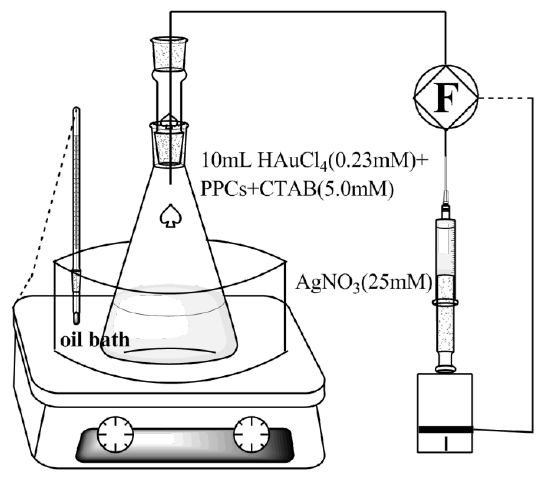
Figure 1. Reaction equipment.